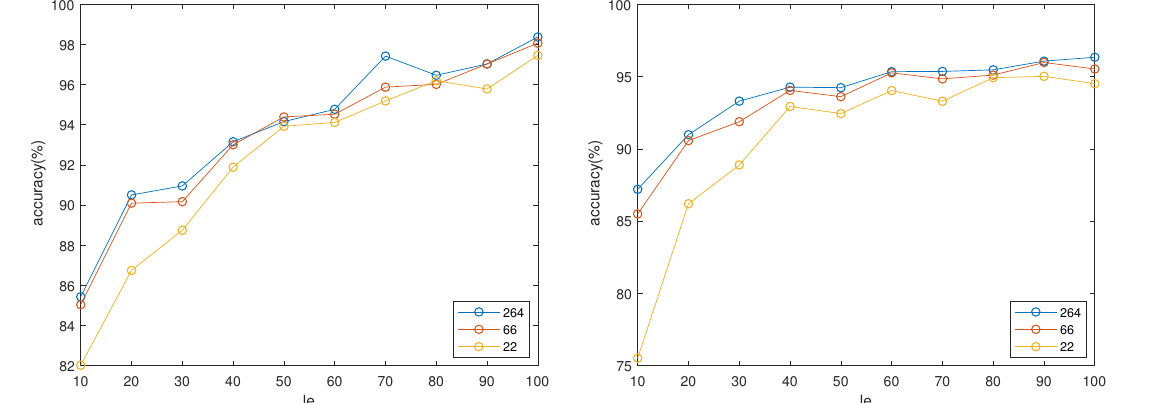
( b ) Variations of classification accuracies over T domain).